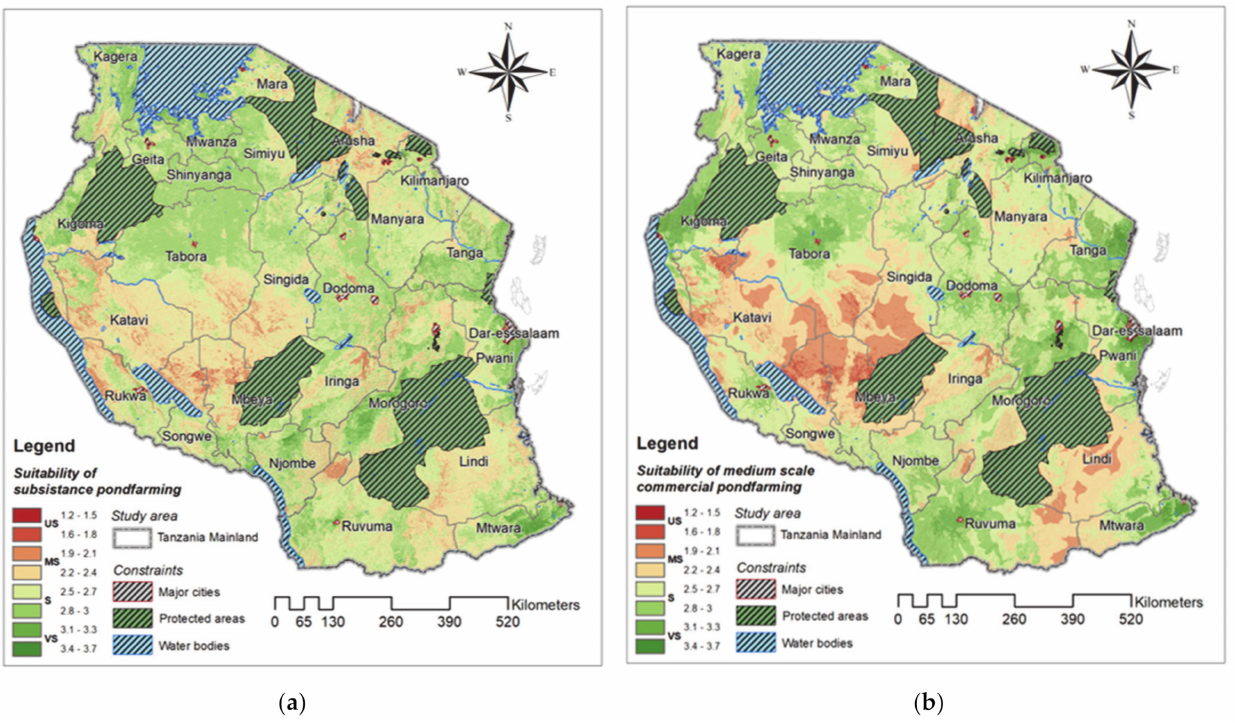
Figure 13. The distribution of suitability scores for; ( a ) small-scale subsistence fish pond farming and; ( b ) medium-scale commercial fish pond farming in